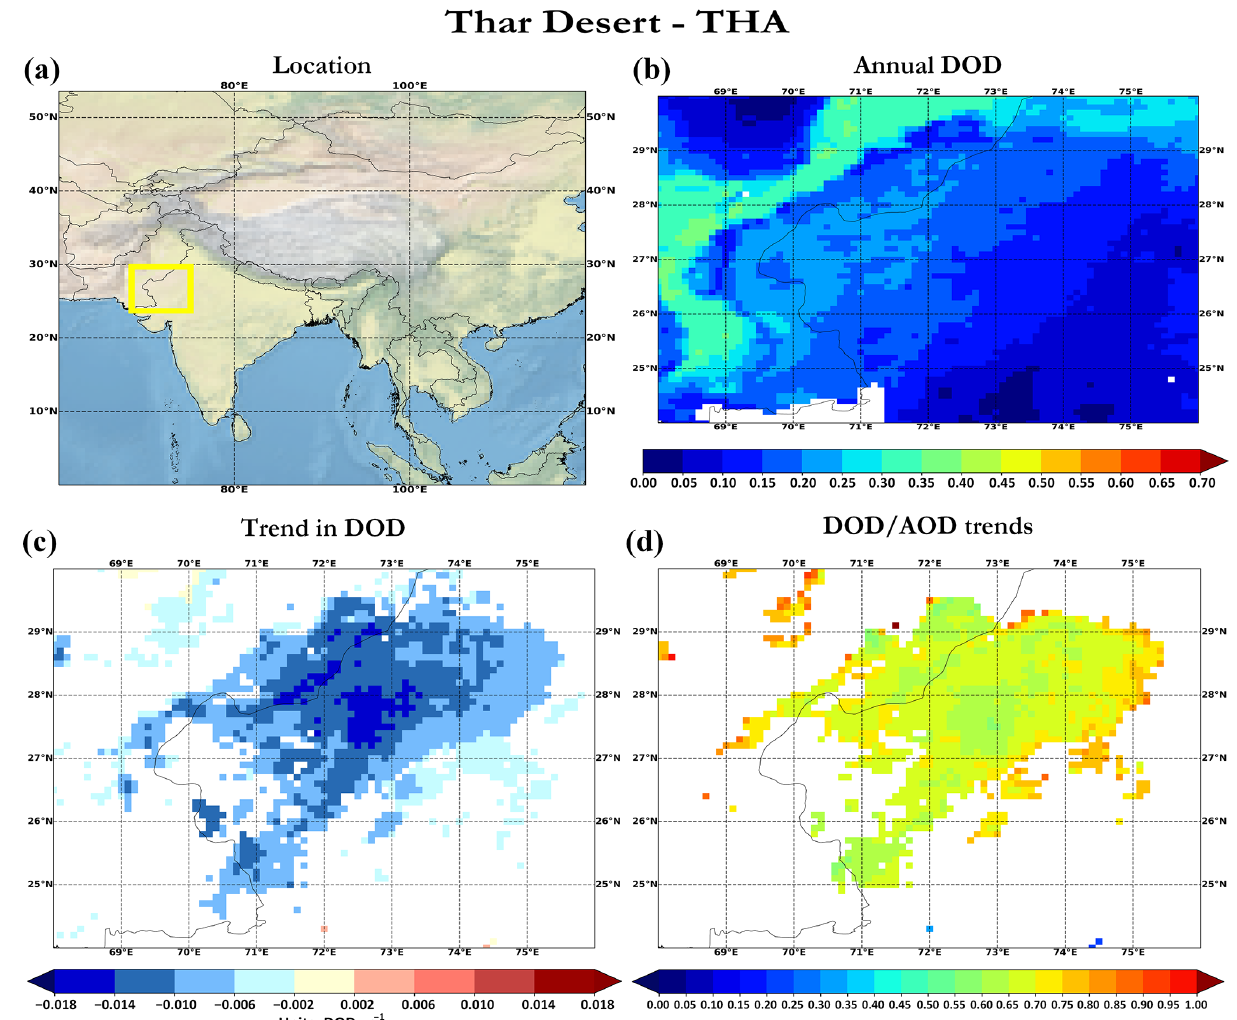
Figure 17. Same as Fig. 10, but for the Thar